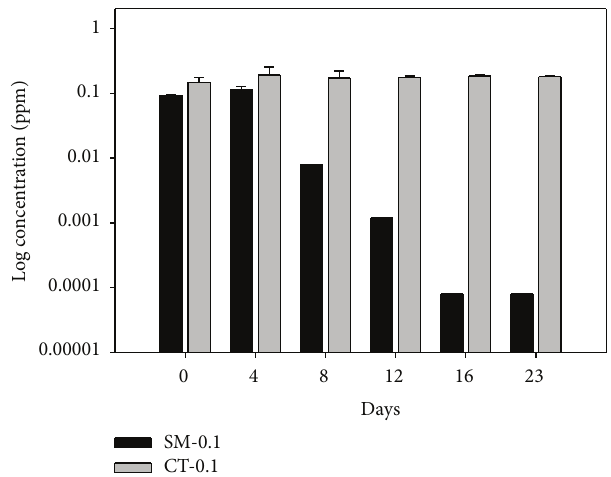
Figure 4: Degradation of sulfamethazine (SM-0.1mg/L) and chlortetracycline (CT-0.1mg/L) over time in groundwater under denitrifying